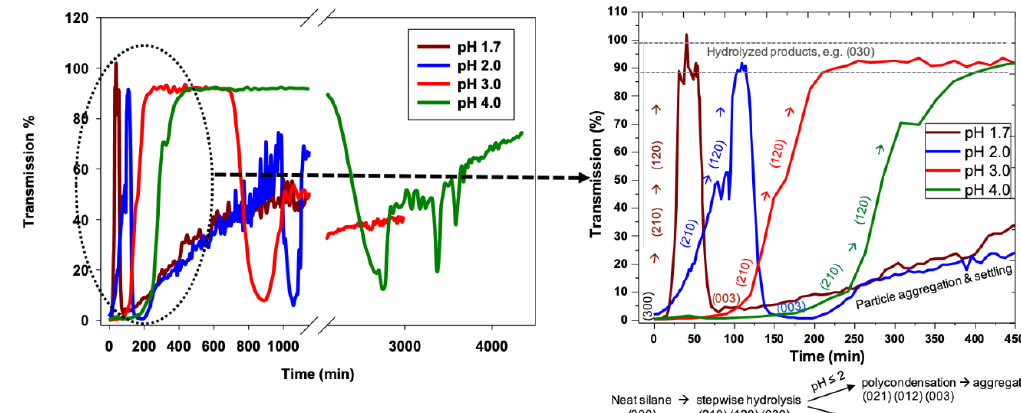
Figure 5. Hydrolysis and condensation kinetics of nPM (0.4 M) at pH 1.7, 2.0, 3.0, and 4.0. Transmissivity data were taken at the height where transmissivity is the lowest at the beginning due to the presence of nPM. The right panel shows the transmission during the first 450 min, with putative (xyz) hydrolysis and condensation process nomenclature according to Figure 1.